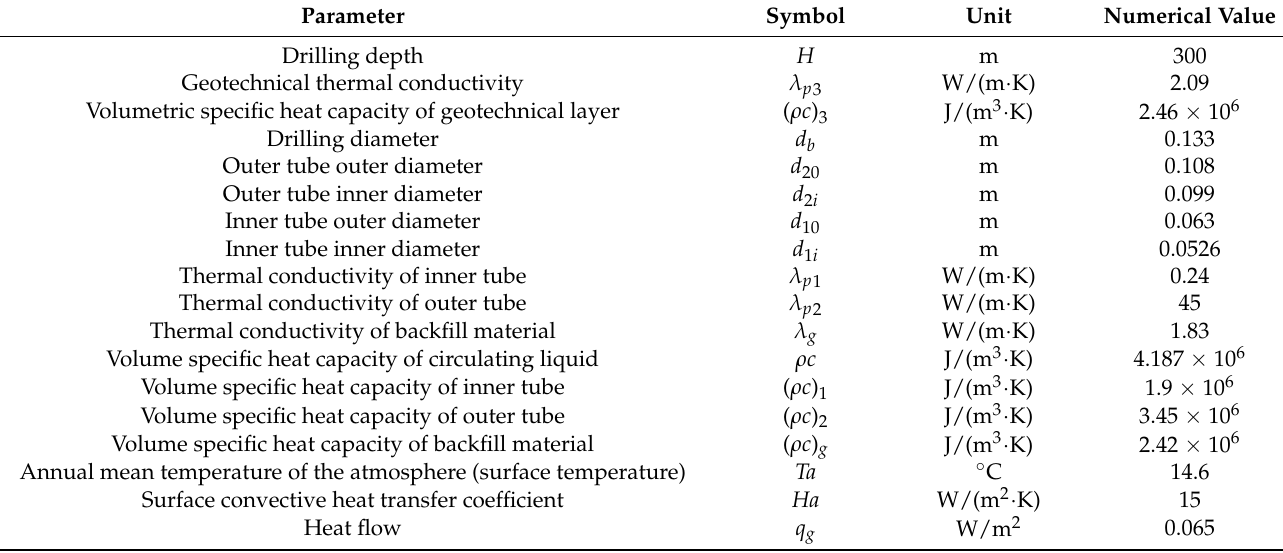
Table 1. Experimental